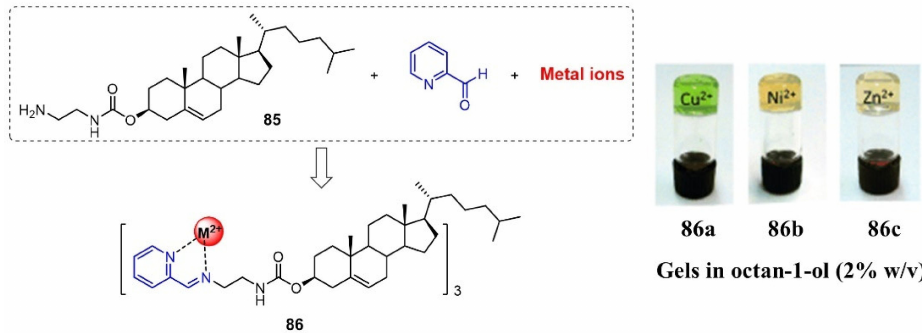
Figure 34. Preparation of gelators 86a – c via subcomponent self-assembly. Reprinted with permission from Ref. [109]. Copyright (2013), John Wiley and